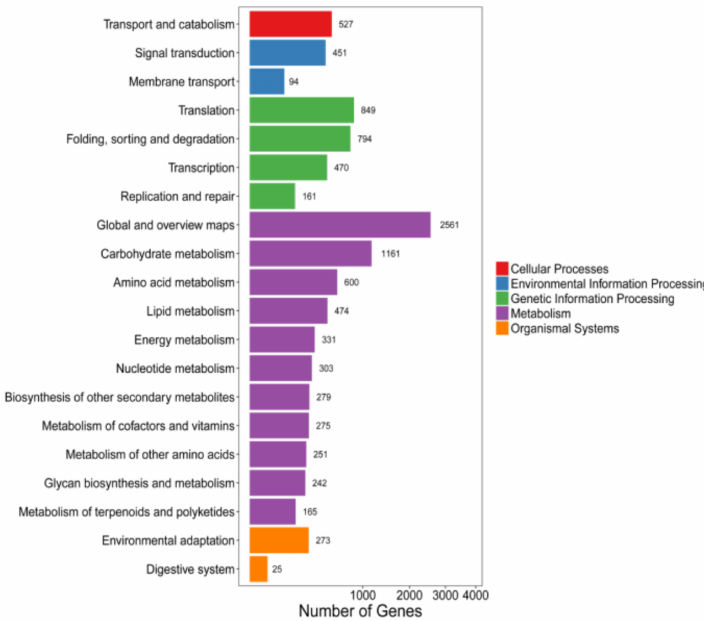
Figure 3. KEGG pathway of differentially expressed Unigenes. Unigenes were assigned to five categories: Cellular processes, environmental information processing, genetic information processing, metabolism, and organismal